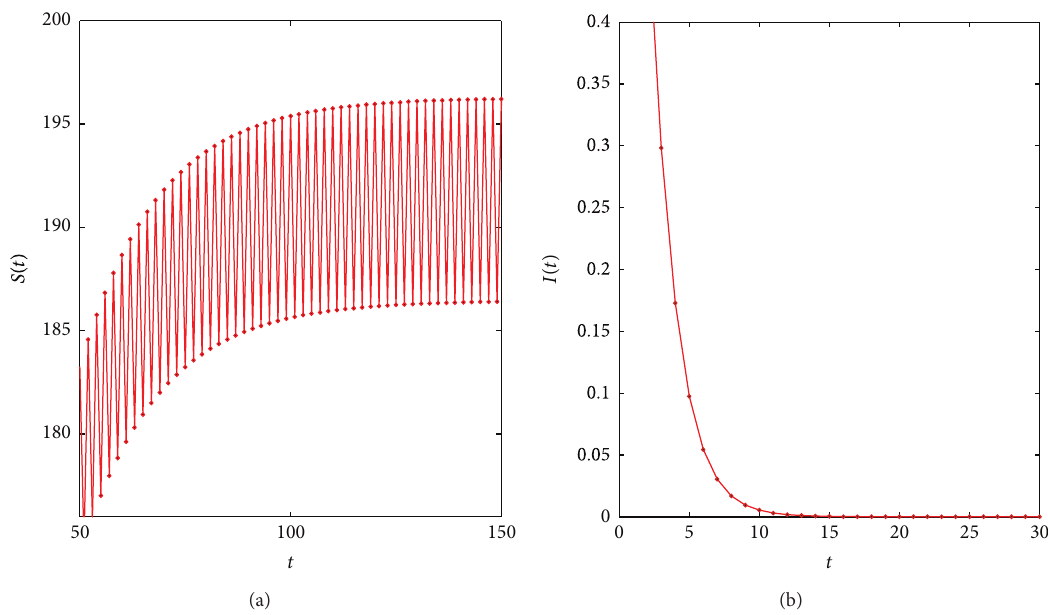
Figure 1: Dynamical behavior of system (2) with 𝜆(𝑡) = 10 , 𝛼(𝑡) = 0 , 𝛽(𝑡) = 𝜇(𝑡) = 0.001 , 𝜀(𝑡) = 𝛾(𝑡) = 0.8 , 𝑇 = 𝜔 = 1 , 𝜃 1 = 0.1 , and (𝜔)) ≃ 0.8026 . (a) Time series of 𝑆(𝑡) . (b) Time series of 𝐼(𝑡) 𝑟(Φ 𝐹−𝑉